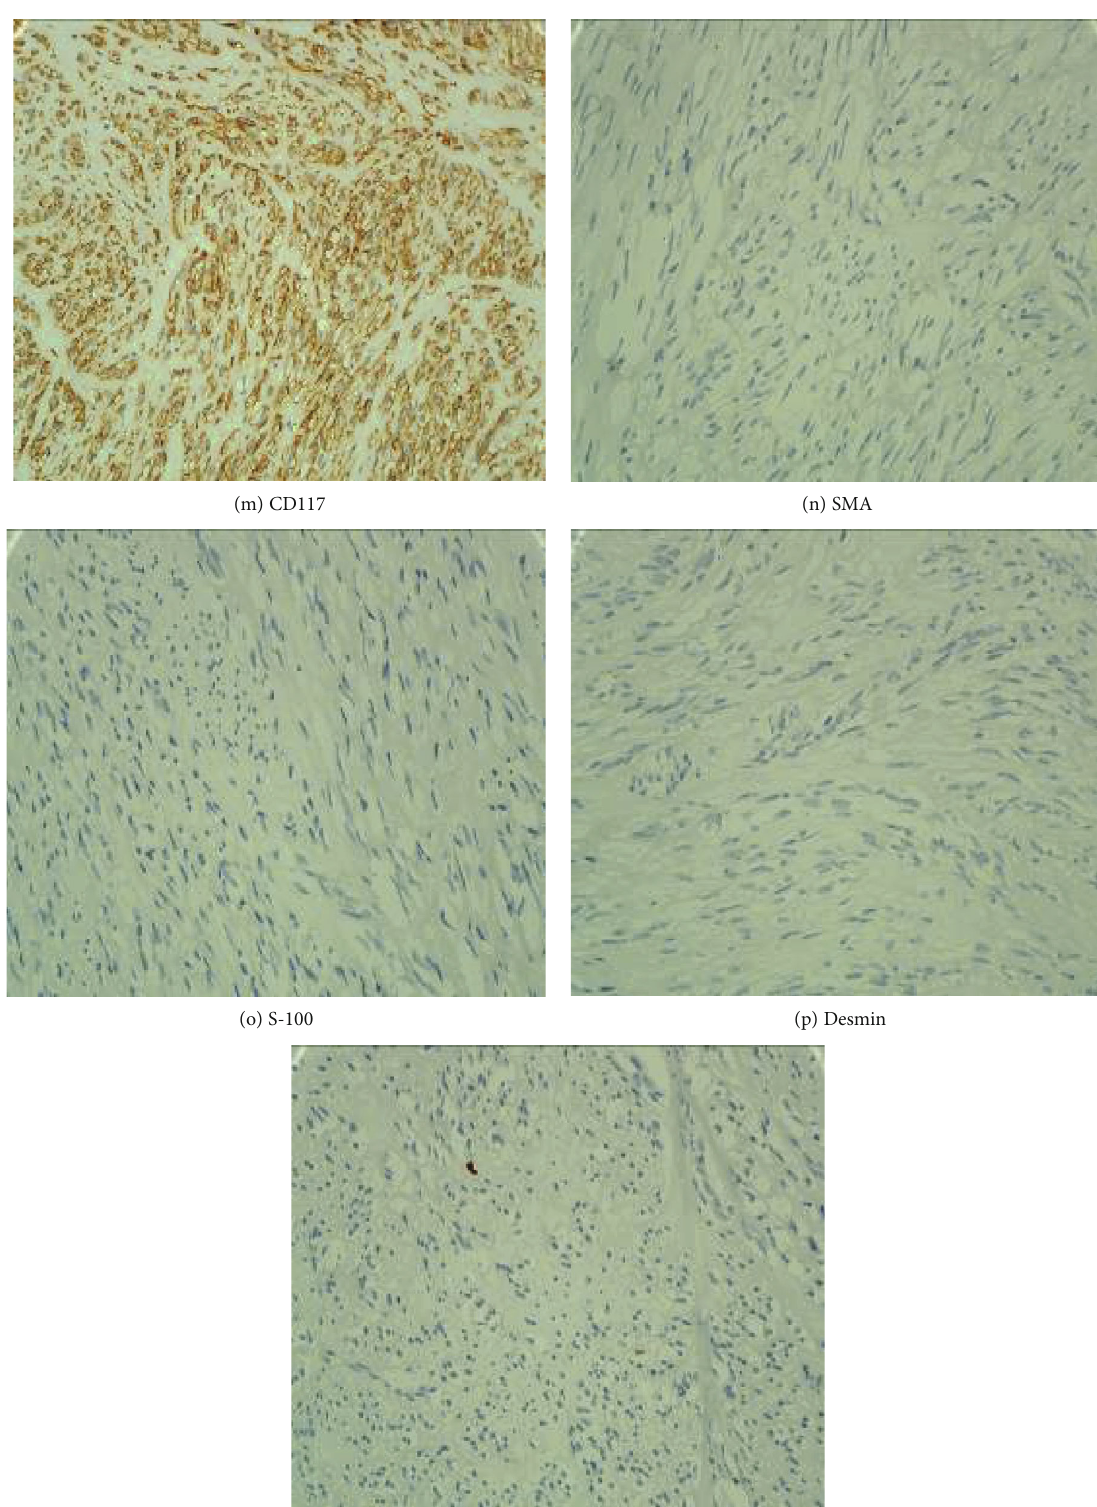
Figure 1: Procedure of OTSC-associated endoscopic muscular dissection for the dissection of small gastric submucosal tumor. (a) A small gastric submucosal tumor of fundus; (b) the tumor was completely absorbed into the transparent cap of OTSC apparatus; (c) the bottom of tumor was ligatured by OTSC; (d) dissection of the tumor; (e) the wound was clipped after the procedure; (f) the resected tumor; (g – j) HE staining, magni fi ed pathological images; (k – q) immunohistochemical staining, CD34(+), DOG-1(+), CD117(+), SMA(-), S-100(-), desmin(-), and Ki-67(+, <